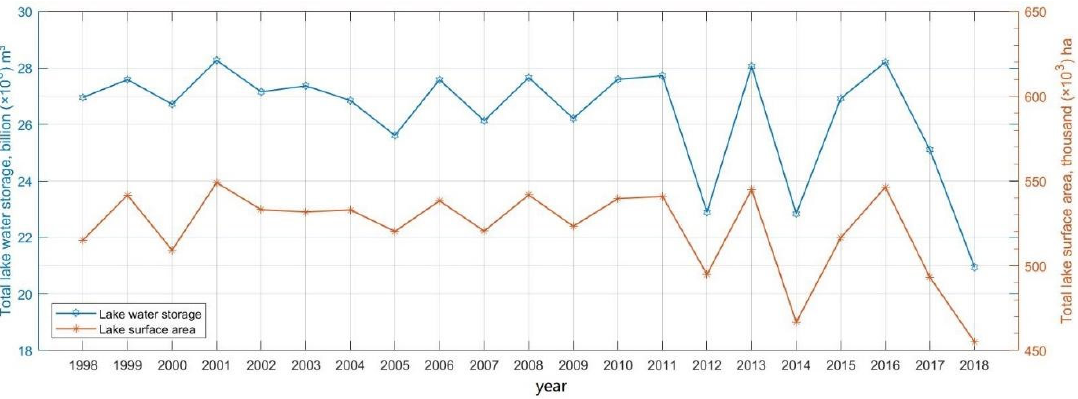
Figure 9. The temporal trend of total lake water storage and lake surface area in Minnesota (1998–2018).